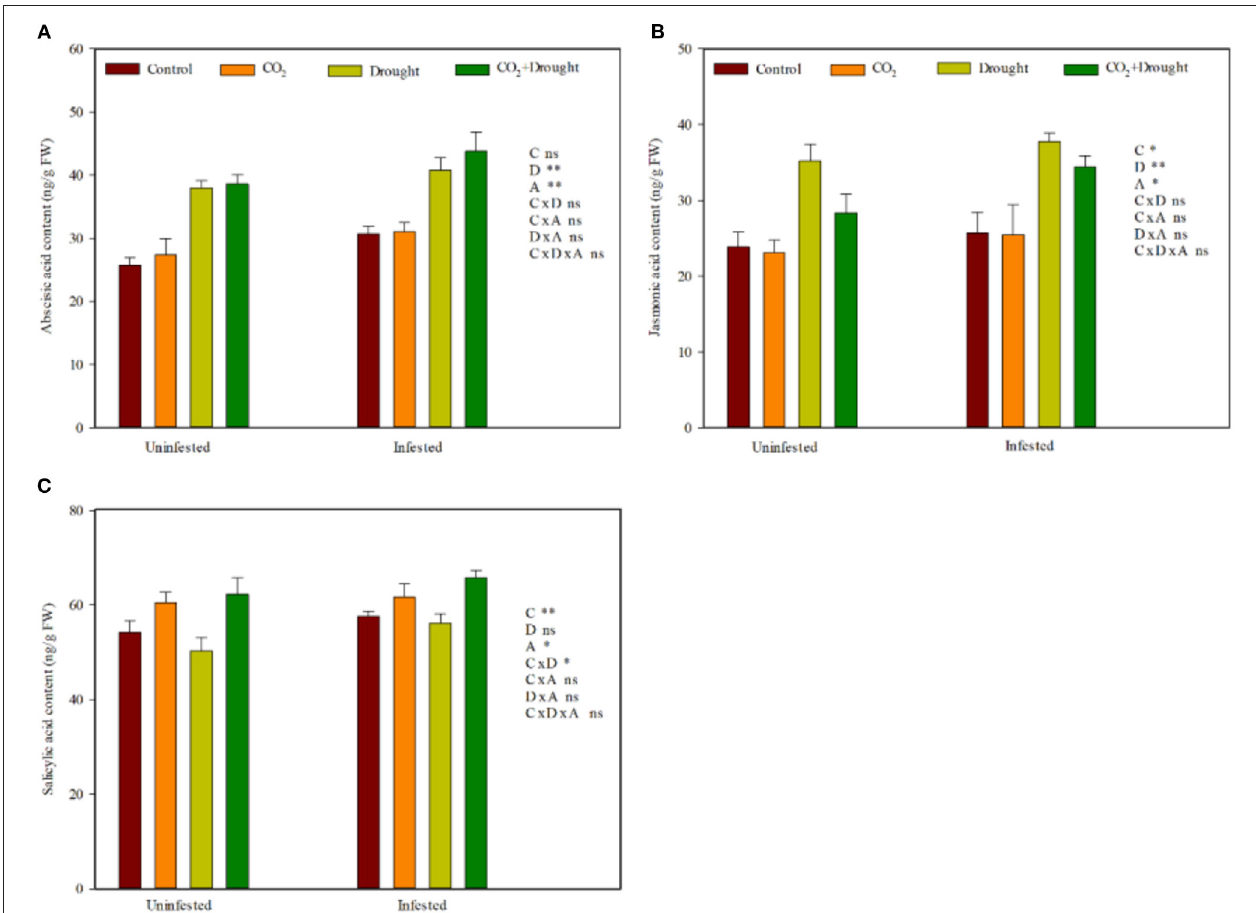
FIGURE 4 | Phytohormone content of Triticum aestivum grown under elevated CO 2 and drought conditions with and without aphid infestation. (A) abscisic acid; (B) jasmonic acid; (C) salicylic acid. Each value shown represents the mean ( ± SE) of three replicates. P- values are provided for three-way ANOVA on the effects of elevated CO 2 (C) , drought (D) , and aphid (A) treatments on phytohormone content. Significant differences: * P < 0.05; ** P < 0.01; ns, P >